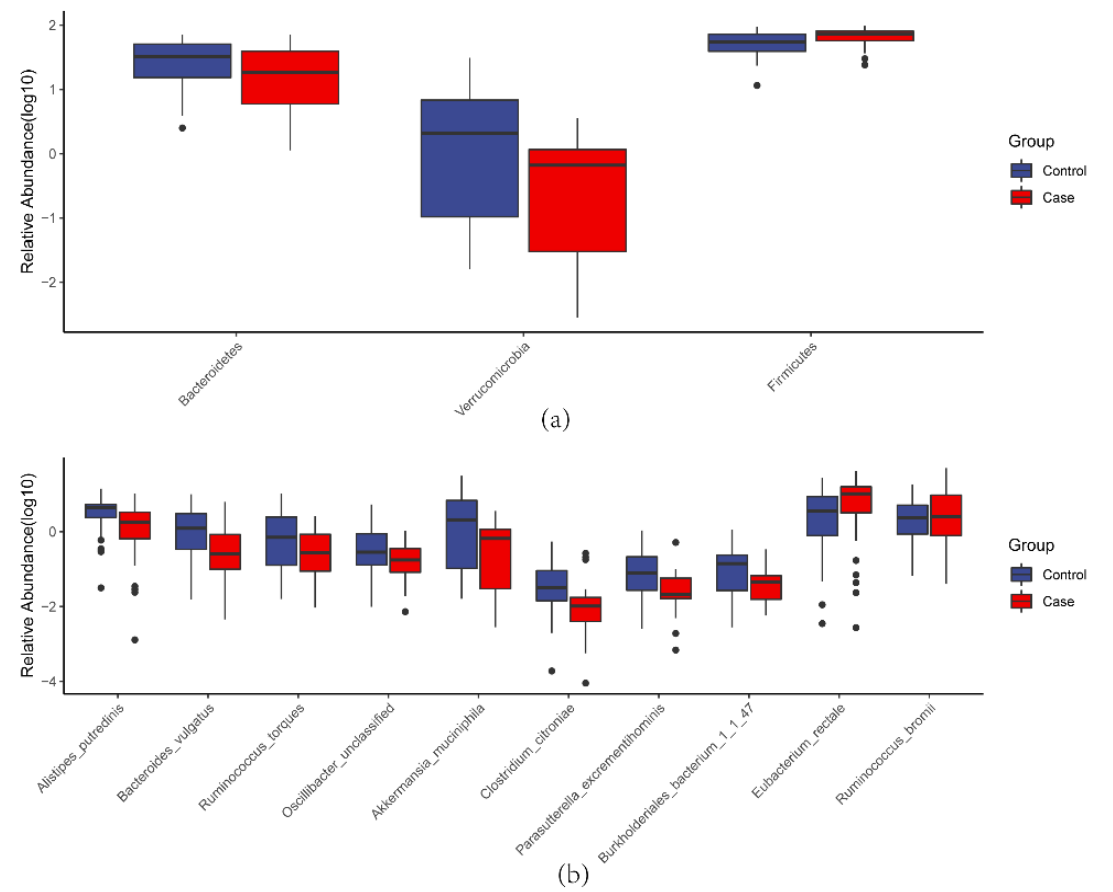
Figure 3. Boxplot of different microbial taxa. ( a ) Different phylum level taxa in two groups. ( b ) Different species level taxa in two